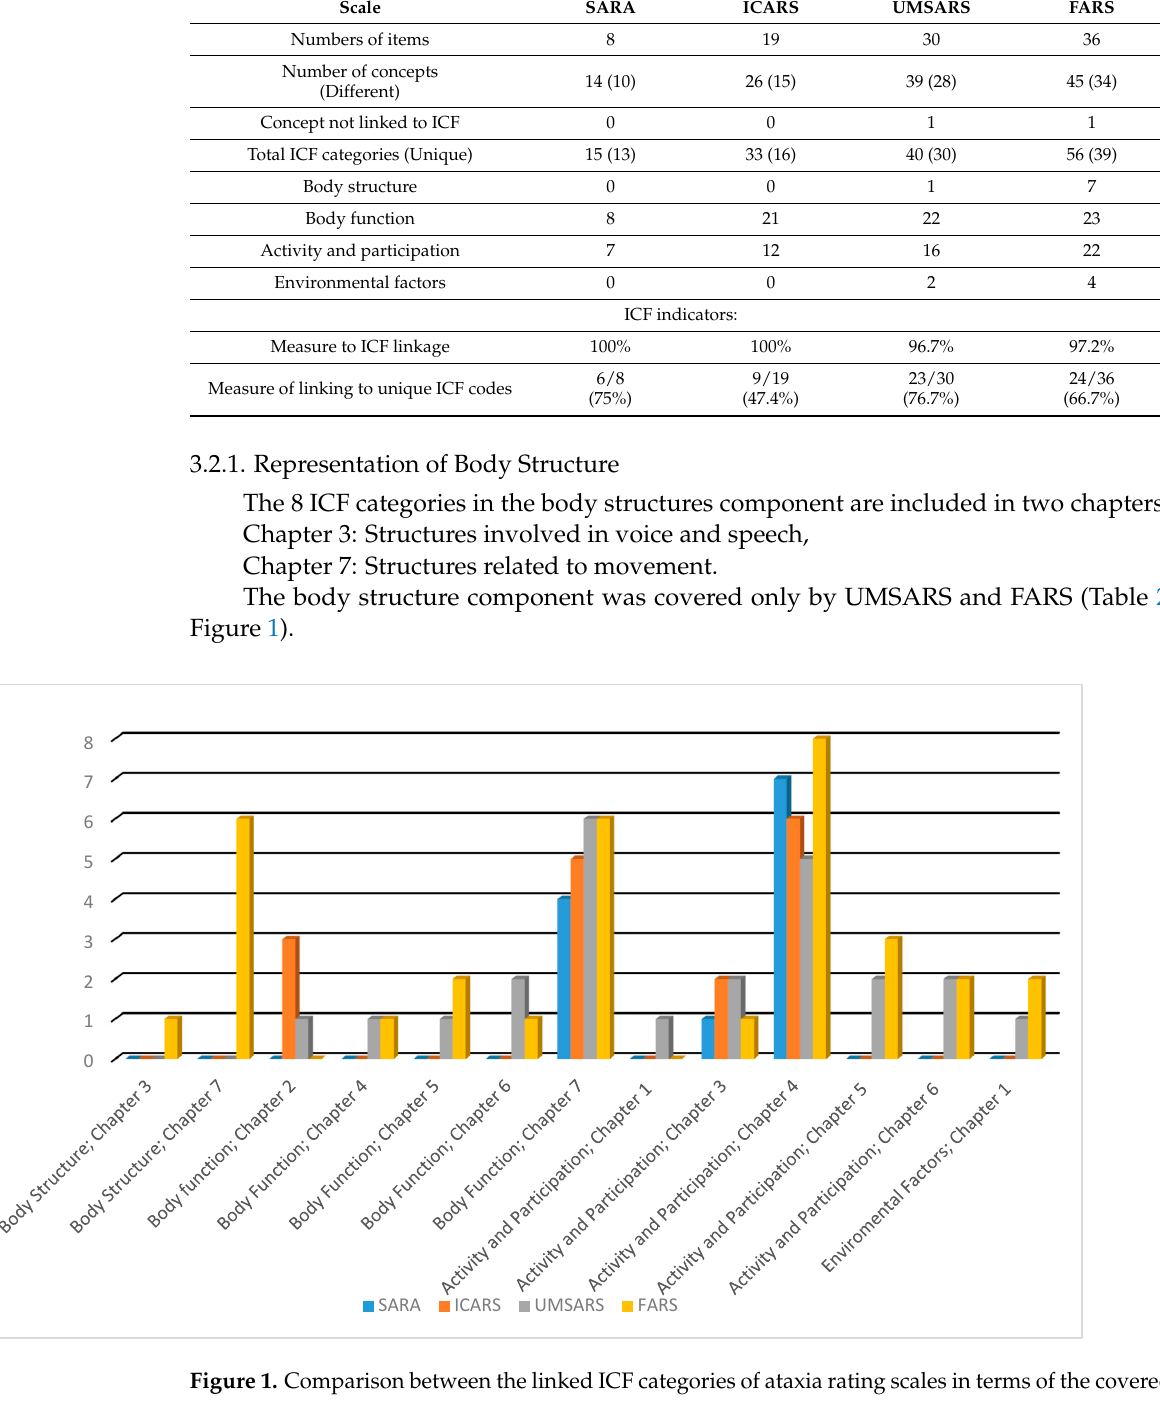
Table 1. Summary of the frequencies of the meaningful concepts, ICF components and categories, and ICF indicators for the included ataxia rating scale. ICARS, international cooperative ataxia rating scales; FARS, Friedreich’s ataxia rating scale; SARA, scale for assessment and rating ataxia; UMSARS, unified multiple system atrophy rating scale.